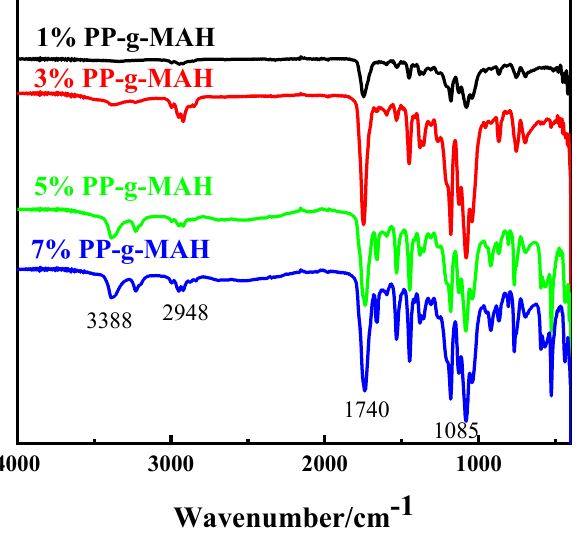
Figure 3. Infrared spectra of TPU/PLA composites with different compatibilizer contents.